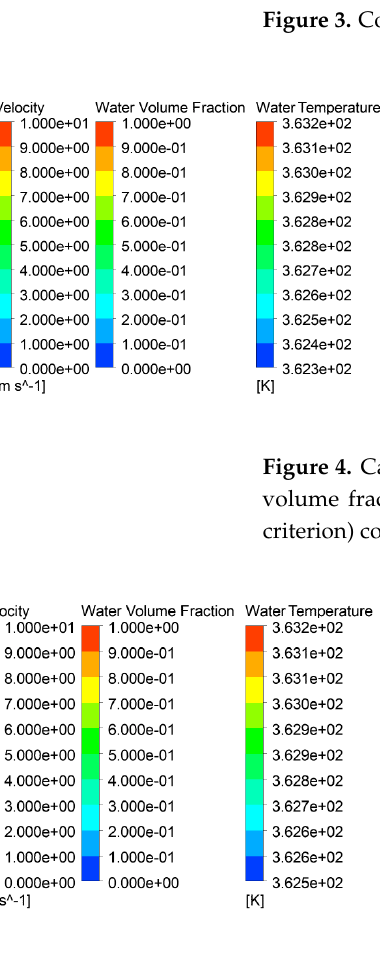
Figure 5. Cavitation at test section mid-plane, σ = 1.676. ( a ) Vector lines; ( b ) distribution f water volume fraction; ( c ) distribution of temperature; ( d ) vortical structures behind the cylinder (Q criterion) colored with